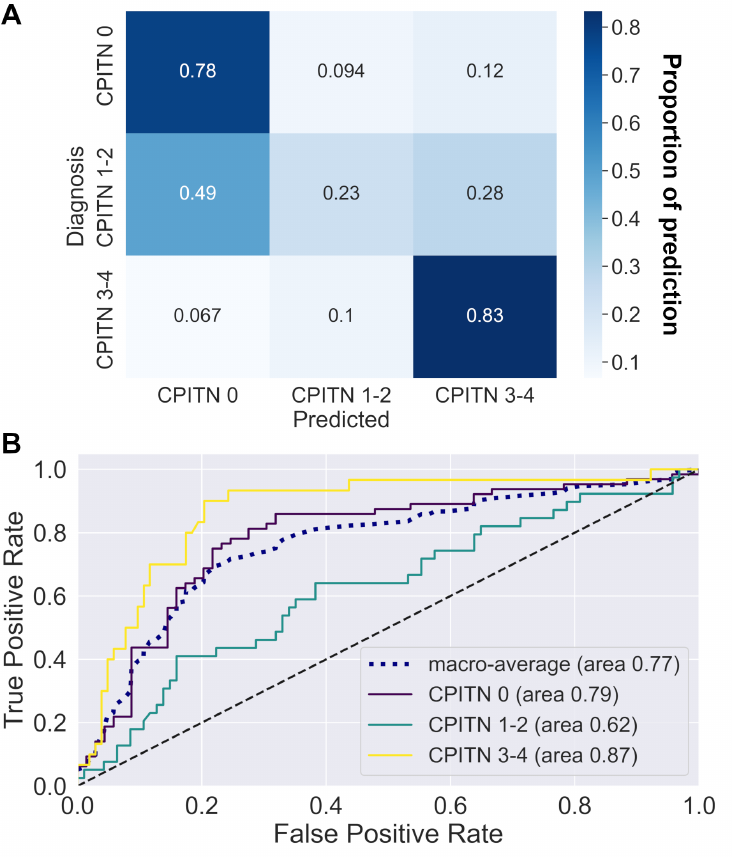
Figure 3. Machine learning model performance. Assessment of the best performing model based on variable selection (BorutaPy), data augmentation, and multilayer perceptron. ( A ) The corre- sponding confusion matrix indicates the proportion of good predictions for each category of CPITN. The complexity of predicting CPITN 1–2 is, thus, highlighted. ( B ) The ROC curves show the relation- ship between the true positive rate (sensitivity) and the false positive rate (1 - specificity) for each CPITN